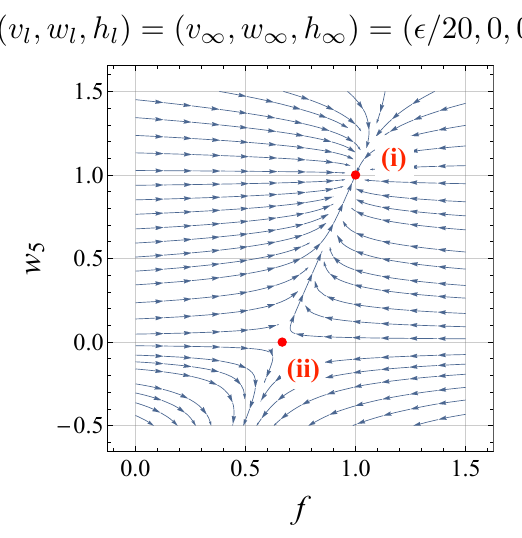
Figure 3 . RG (cid:13)ow of the parameters f and w points (i) and